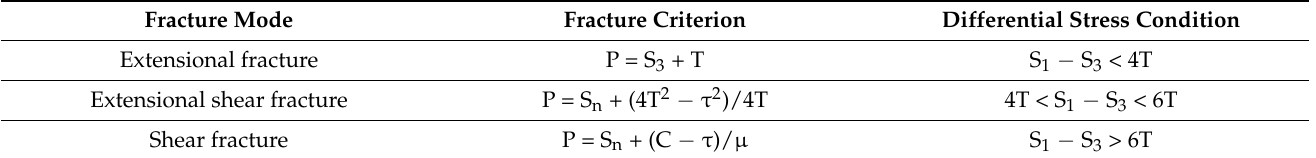
Table 1. The fracture mode and criterion of rocks in different differential stress [26]. Fracture Mode Fracture Criterion Differential Stress Condition Extensional fracture P = S 3 + T S 1 − S 3 < 4T Extensional shear fracture P = S n + (4T 2 − τ 2 )/4T 4T < S 1 − S 3 < 6T Shear fracture P = S n + (C − τ )/ µ S 1 − S 3 > 6T Where P is fracture pressure (MPa), S 1 is maximum principal stress (MPa), S 3